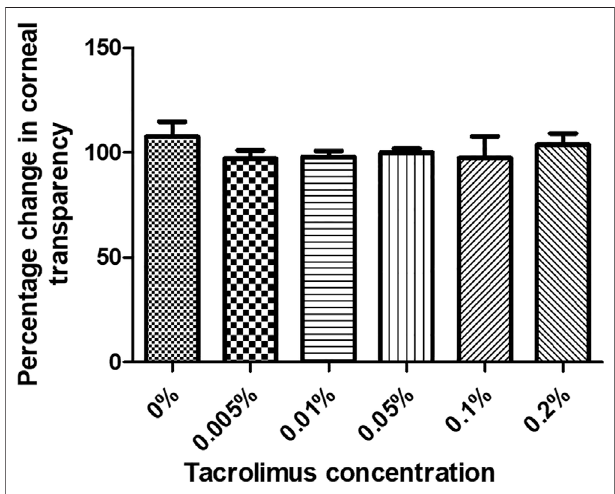
FIGURE 2 | The effect of tacrolimus treatment on corneal transparency. Percentage change in corneal transparency from pretreatment measurements is represented by bars. Each bar shows the average from three corneas ( n = 3). Error bars represent standard